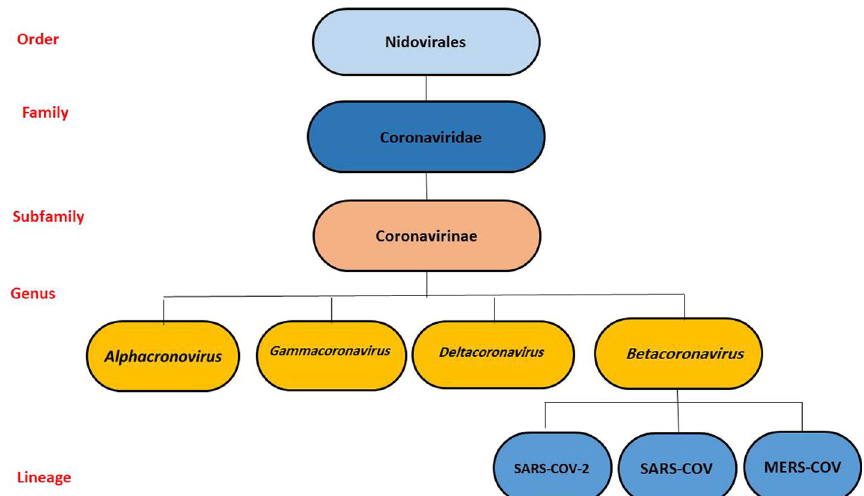
Fig. 1 Phylogenetic form: phylogenetic analysis of SARS‑CoV‑2 and Betacoronavirus genomes of other viruses in the Orthocoronavirinae subfamily [1]